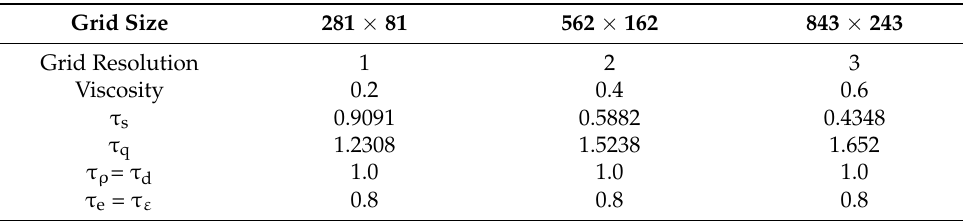
Table 2. The modeling parameters and grid size/grid resolution of LBM simulations.